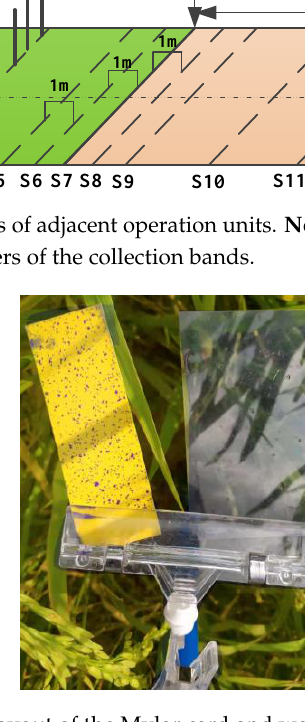
Figure 17. Layout of the Mylar card and water-sensitive paper.